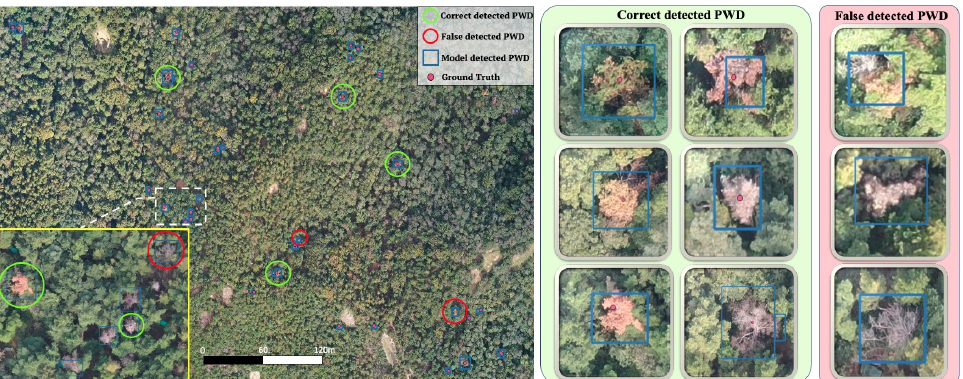
Figure 7. Prediction result using the Goomisi Goaeup dataset described in Table 5. The bottom left corner shows a magnification of the content in the white dash box. We selected some predicted bounding boxes and marked them with circles. The instances of enlarged disease are shown in the right figure; the green panel shows correctly detected PWD while the red panel represents the false alarms that show an appearance similar to that of a diseased